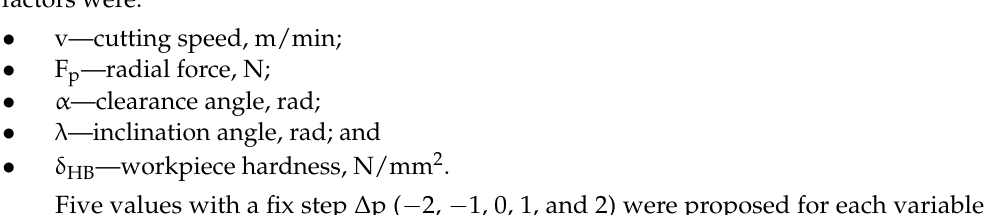
Figure 9. Geometric schematic for radius calculus.